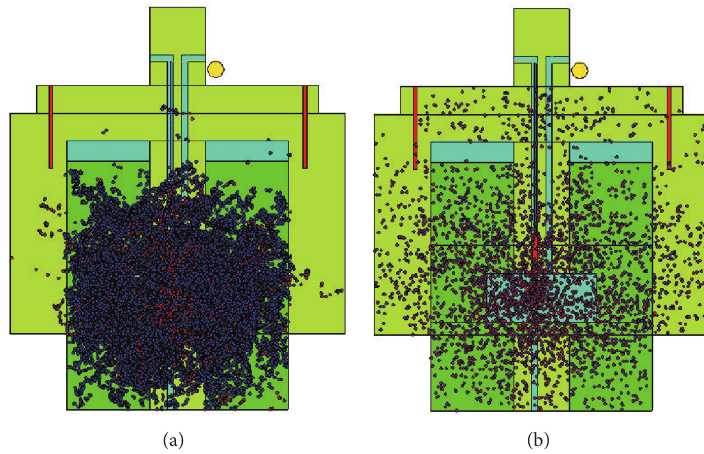
Figure 8: (a) Neutron and (b) gamma-ray interactions with the irradiator.